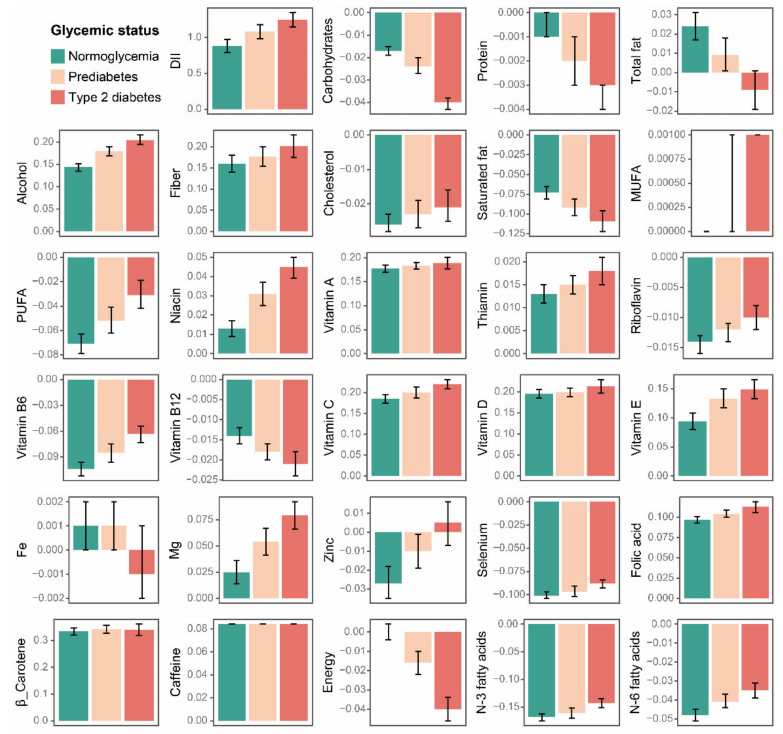
Figure 3. Comparison of the DII component scores by baseline glycemic status. Data are presented as the weighted mean value and 95%CI. DII: dietary inflammatory index; MUFA: monounsaturated fatty acids; and PUFA: polyunsaturated fatty